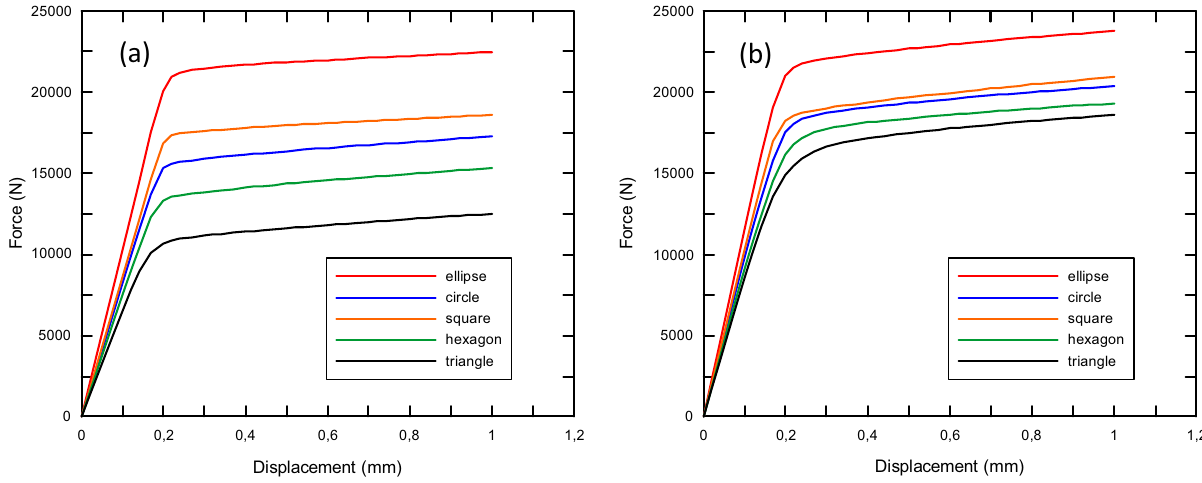
Figure 3: The force – displacement curves of the stainless - steel sheet metal ( a ) linear arrangements and ( b ) staggered arrangements.